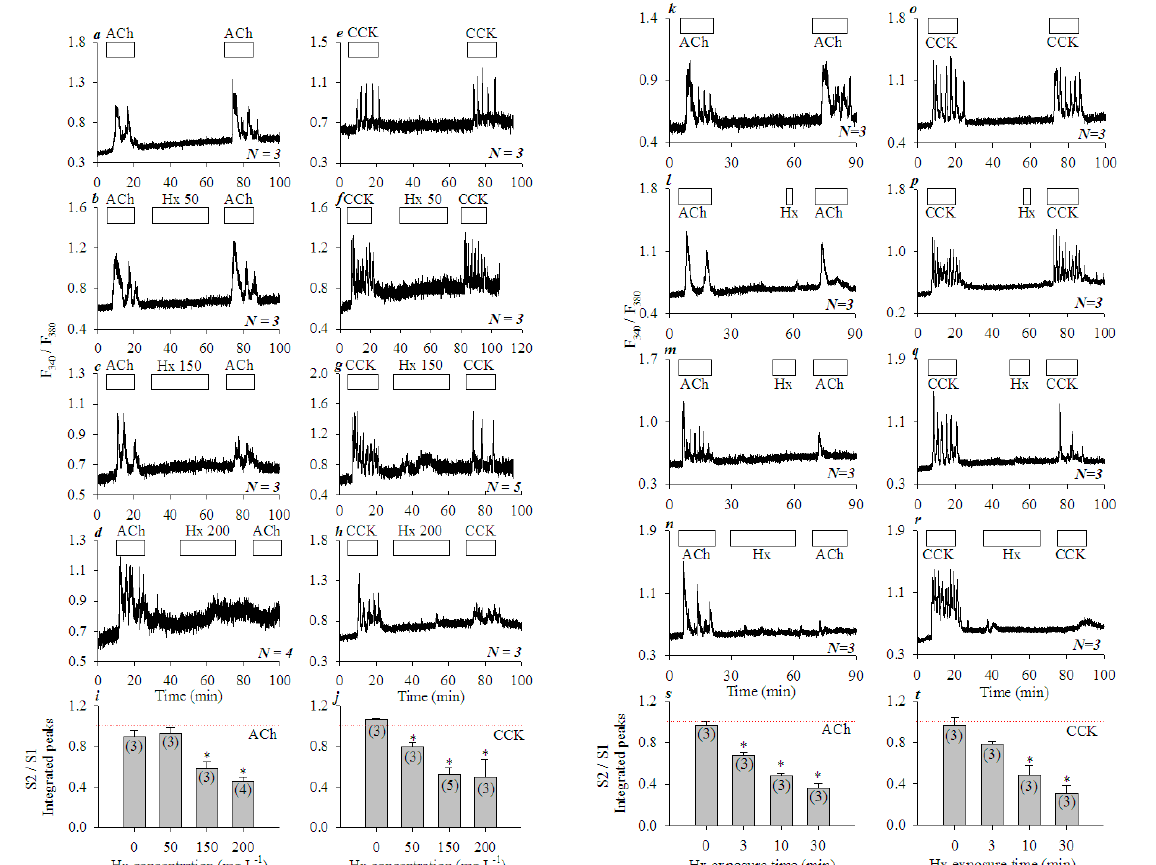
Figure 1. Mixed histones (Hx) inhibited concentration ‐ and time ‐ dependent calcium oscillations induced by ACh or CCK in isolated rat pancreatic acini. Fura ‐ 2 ‐ loaded rat pancreatic acini